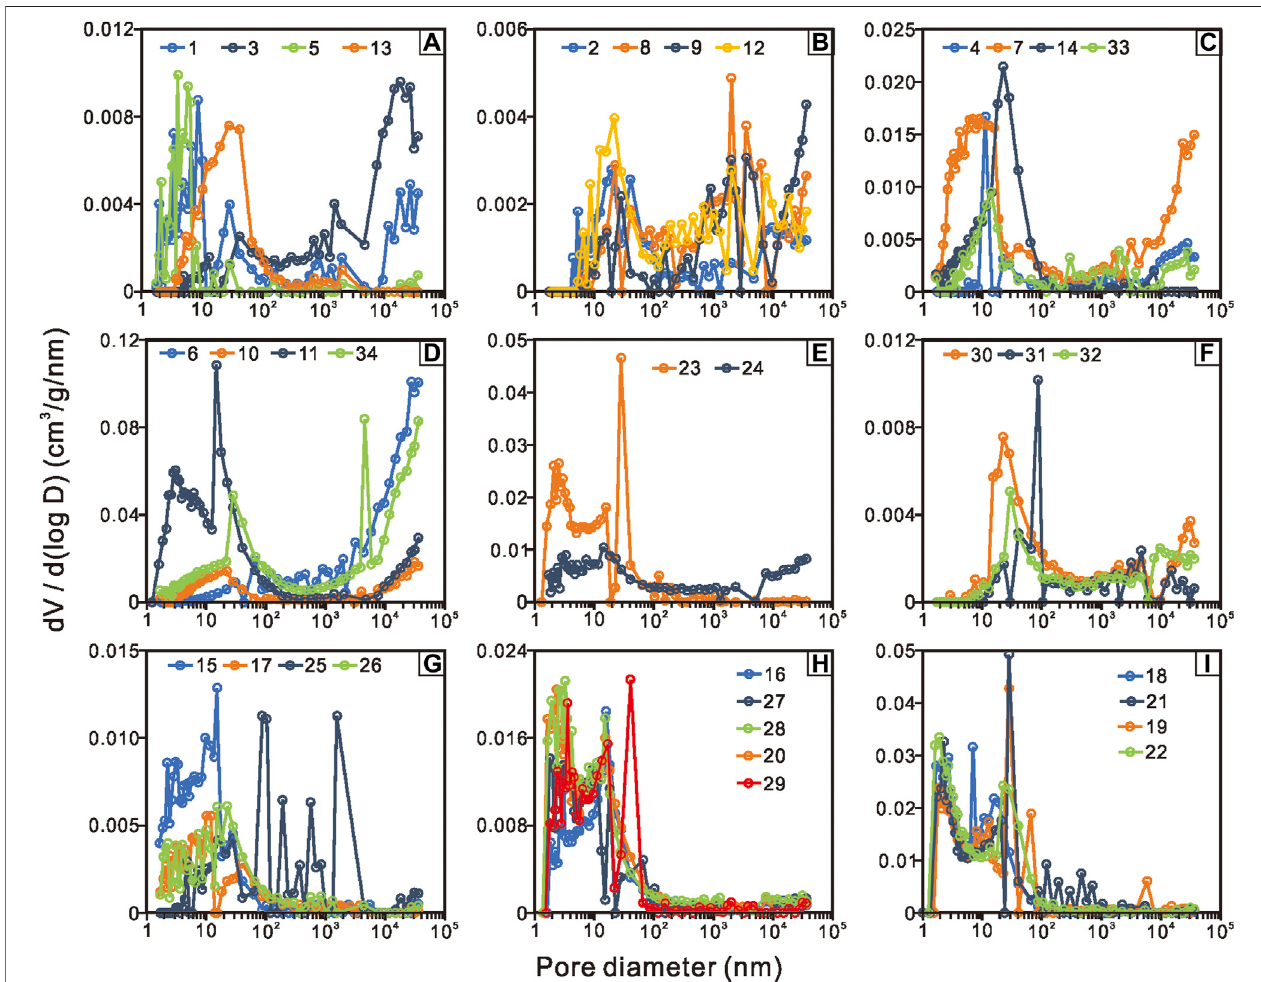
FIGURE 4 | Pore size distribution of all the shale samples. (A – D) shales from Es 4upper ; (E, F) shales from Es 3lower ; (G – I) shales from Es 3middle .